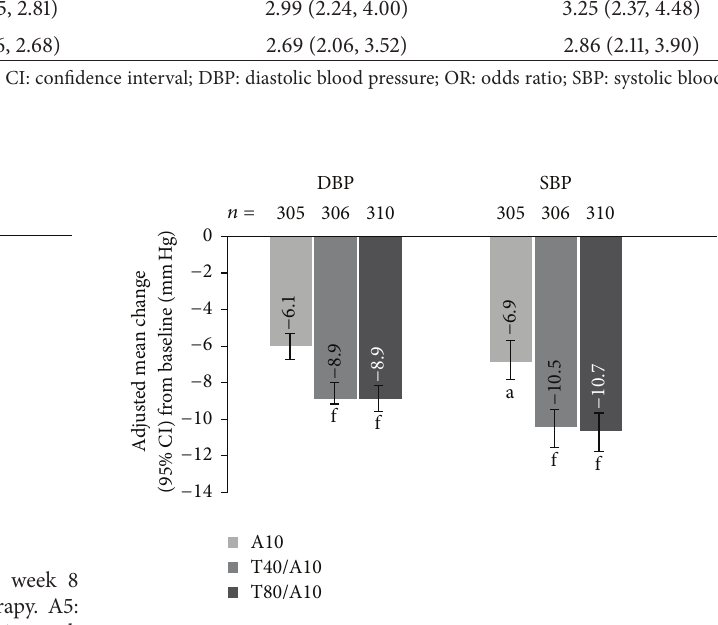
monotherapy and 54.4% of those uptitrated to A10 compared with 68.9% of patients switched to T40/A5 and 69.7%